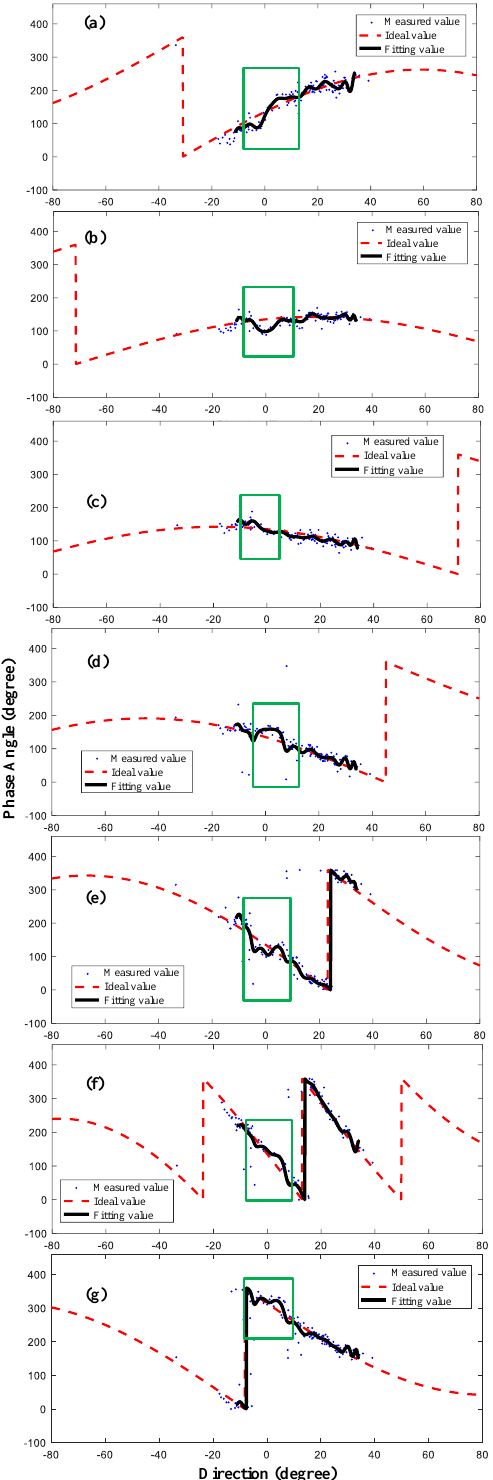
Figure 6. Array phase value measurements at 12.5 MHz. ( a ) Antenna 2; ( b ) Antenna 3; ( c ) Antenna 4; ( d ) Antenna 5; ( e ) Antenna 6; ( f ) Antenna 7; and, ( g ) Antenna